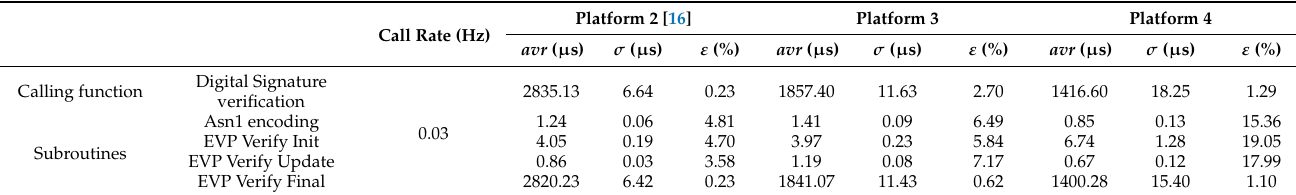
Table 6. Software profiling analysis results of the digital signature verification and its subroutines obtained on the three embedded platforms with the set of parameters S1 in Table 3. © [2020] IEEE. Extended, with permission, from